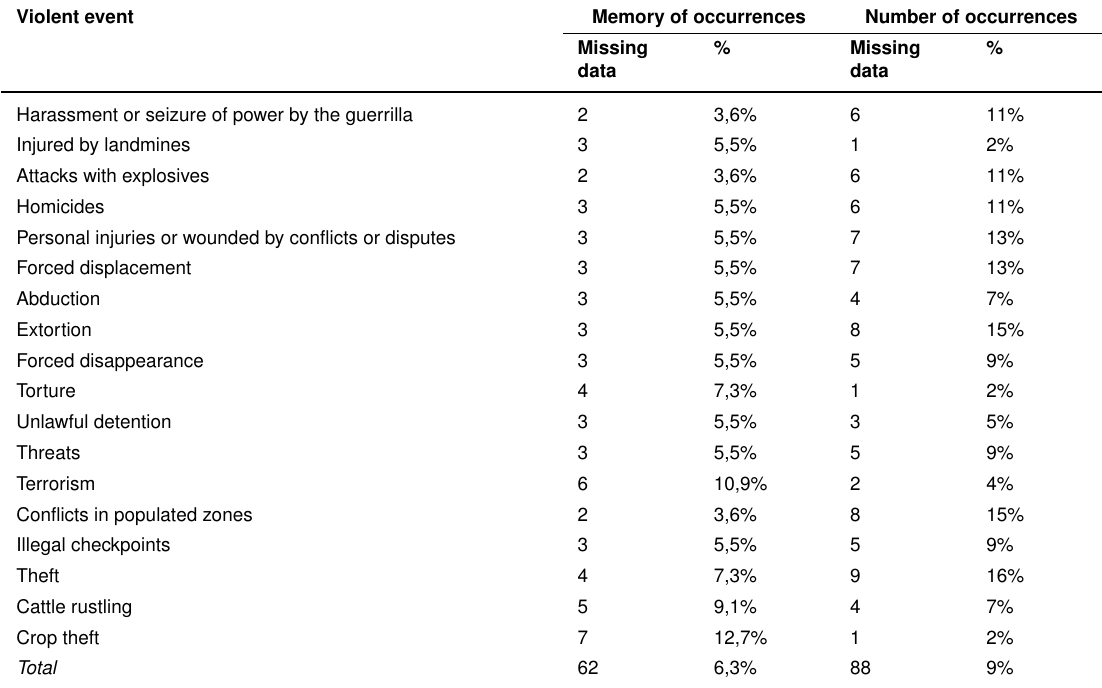
Table A1. Amounts of imputed missing data in the data file obtained after applying a survey in 55 Miranda’s inhabitants. Violent event